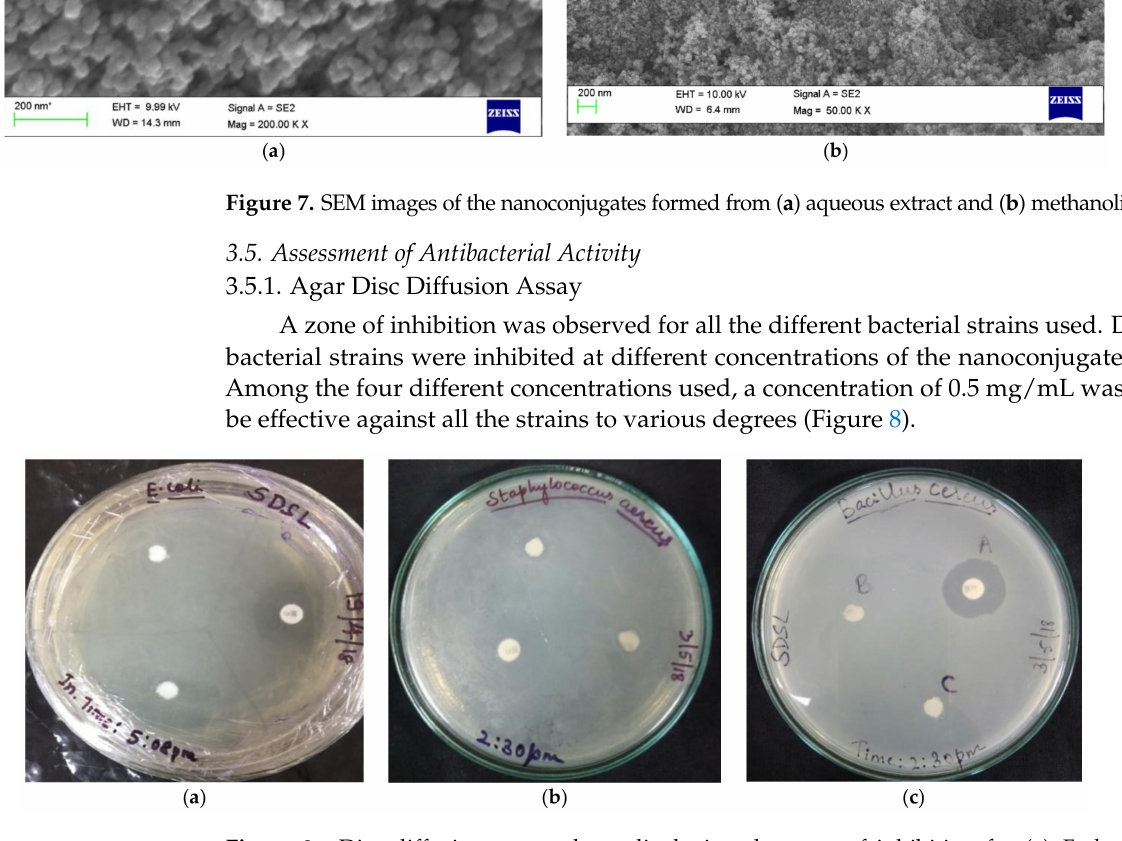
Figure 8. Disc diffusion assay plates displaying the zone of inhibition for ( a ) Escherichia coli ( b ) Staphylococcus aureus and ( c ) Bacillus cereus